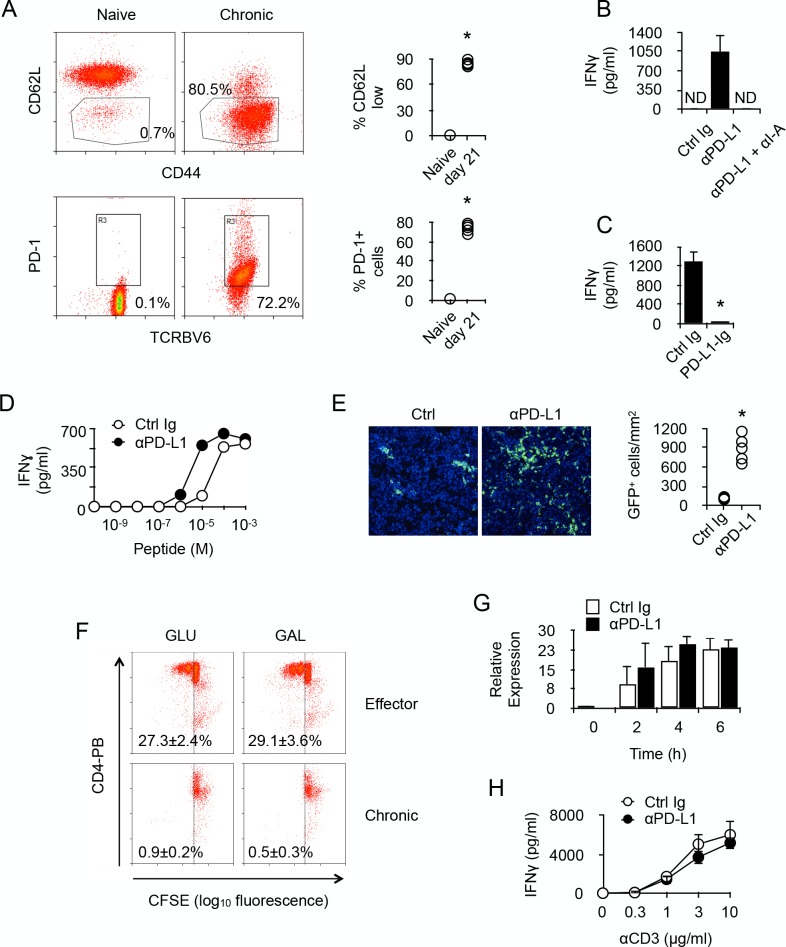
PD-1 controls the activity of chronic anti-male CD4 +T cells.(A) Phenotype of chronic anti-male CD4+ T cells. Spleen CD3+ cells from normal Marilyn mice (naive) or from non-irradiated B6 male (H-2b) Rag2-/- Il2rg-/- recipients 21 days after reconstitution with purified Marylin CD4+ TCRBV6+ T cells (chronic), were analyzed for their expression of CD44, CD62L and PD-1 by flow cytometry. Represented data are means ± SEM. Data presented are representative of two independent experiments with 4–5 mice in each experimental group. * indicates p=0.0079 (compared to naive) by the Mann-Whitney test. (B) IFNγ production in the culture supernatant of spleen cells isolated from non-irradiated male B6 (H-2b) Rag2-/- Il2rg-/- recipients 21 days after reconstitution with purified Marylin CD4+ TCRBV6+ T cells. Control, anti-PD-L1 and/or anti-I-A/I-E neutralizing antibodies were added to the cultures. Represented data are means ± SEM of five replicates. Data presented are representative of three independent experiments. ND indicates below detection limits. (C) IFNγ production by CD4+ T cells purified from non-irradiated B6 male (H-2b) Rag2-/- Il2rg-/- recipients 21 days after reconstitution with purified Marylin CD4+ TCRBV6+ T cells. Cells were stimulated with anti-CD3/CD28 antibodies in the presence of immobilized Ctrl Ig or PD-L1-Ig fusion proteins. Represented data are means ± SEM of five replicates. Data presented are representative of three independent experiments. * indicates p=0.0079 (compared to Ctrl) by the Mann-Whitney test. (D) IFNγ production by CD4+ T cells purified as in C and stimulated with male peptide-loaded B6 Cd3-/- bone marrow-derived dendritic cells in the presence of Ctrl or anti-PD-L1 neutralizing antibodies. Represented data are means ± SEM of three replicates. Data presented are representative of two independent experiments. (E) Cell counts of GFP+ T cells infiltrating the liver of non-irradiated male B6 (H-2b) Rag2-/- Il2rg-/- recipients 21 days after reconstitution with purified Marylin GFP+ CD4+ TCRBV6+ T cells and that received i.p. Ctrl or anti-PD-L1 neutralizing antibodies. * indicates p=0.0079 (compared to Ctrl antibody group) by the Mann-Whitney test. Represented data are means ± SEM. Data presented are representative of two independent experiments with 4–5 mice in each experimental group. (F) In vitro proliferation is assessed by fluorescent decay in CFSE-stained chronic or effector T cells after anti-CD3/CD28 stimulation. (G) IFNγ mRNA relative expression by anti-CD3/CD28-stimulated CD4+ T cells purified from non-irradiated B6 male (H-2b) Rag2-/- Il2rg-/- recipients 21 days after reconstitution with purified Marylin CD4+ TCRBV6+ T cells. Purified T cells were stimulated in the presence of anti-PD-L1 or control antibodies for 2, 4 and 6 hr. No significant difference was found between the two conditions. (H) IFNγ production by anti-CD3/CD28-stimulated CD4+ T cells purified from non-irradiated B6 male (H-2b) Rag2-/- Il2rg-/- recipients 21 days after reconstitution with purified Marylin CD4+ TCRBV6+ T cells. Purified T cells were stimulated in the presence of anti-PD-L1 or control antibodies. No significant difference was found between the two conditions.